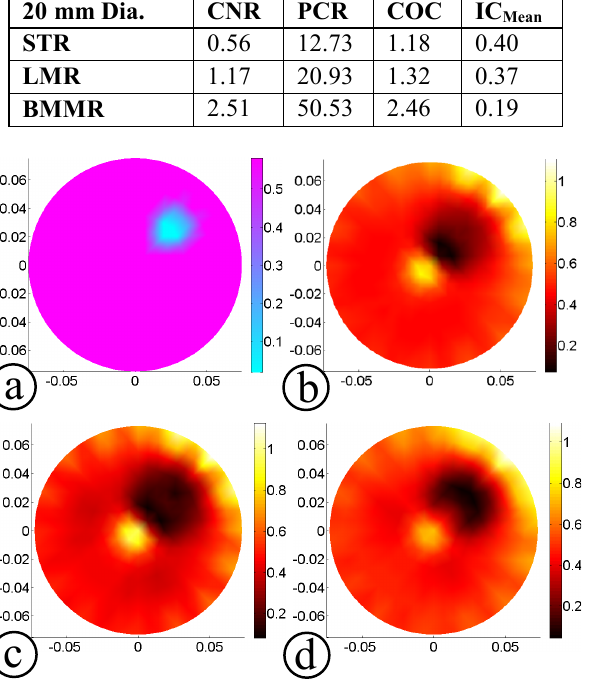
Fig .9: Conductivity reconstruction of the phantom with inhomogeneity (D = 30 mm, L = 37.5 mm) near electrode No.-3 ( λ = 0.0001 ): (a) original object, (b) image with STR, (c) image with LMR, (d) image with BMMR.